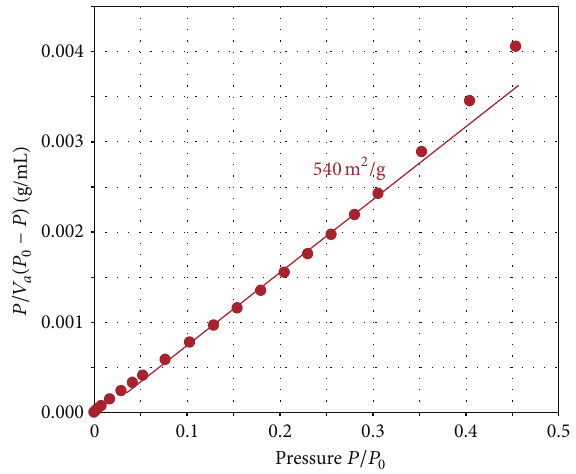
Figure 6: BET (Brunauer-Emmett-Teller) analysis of the absorp- tion-desorption curves in Figure 4. A specific surface area of 540 m 2 /g was